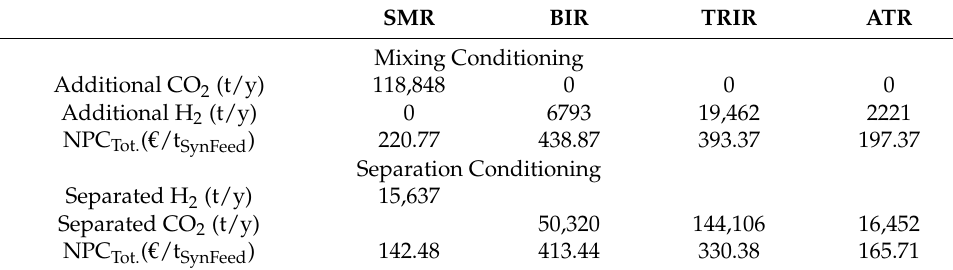
Table 18. Mass flows and net production costs of conditioned